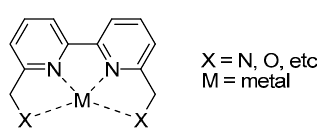
Figure 1. Multidentate chelation of metal center by 6,6’-substituted 2,2’-bipyridine.